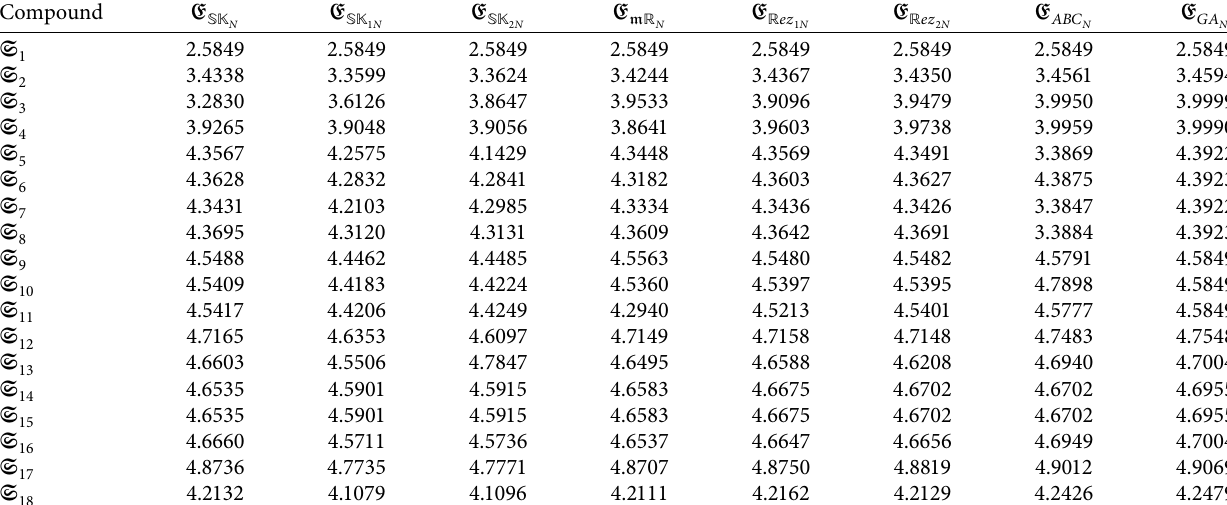
Table 3: Numerical values of neighborhood version of entropies.